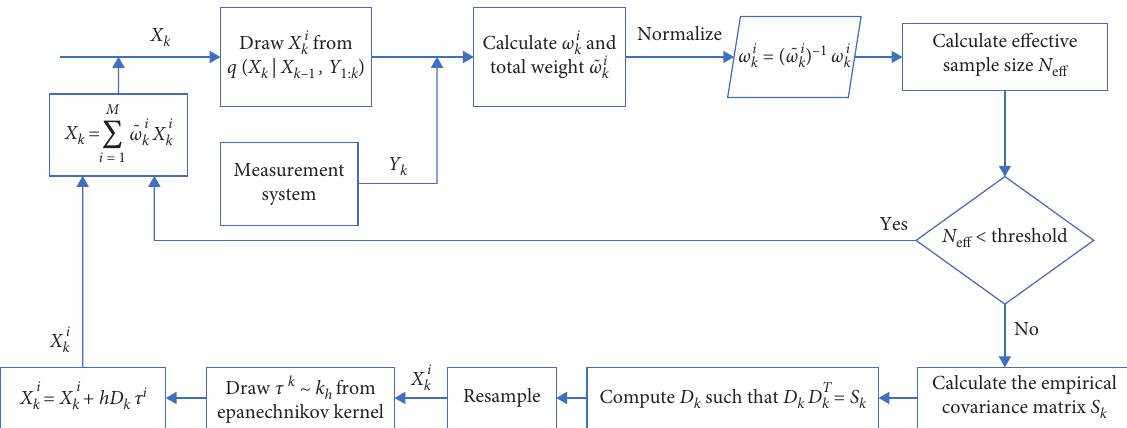
Figure 4: The flow chart of the RPF algorithm.